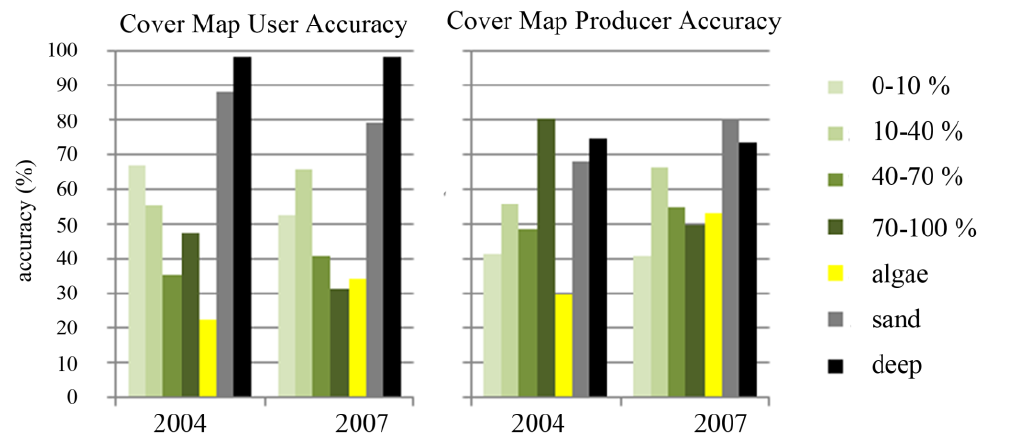
Figure 7. User (left) and Producer (right) accuracy values for the 2004 and 2007 seagrass cover maps. Note high accuracy values for sand and deep classes, which explains the difference between ―overall‖ and ―seagrass overall‖ accuracies in Figure